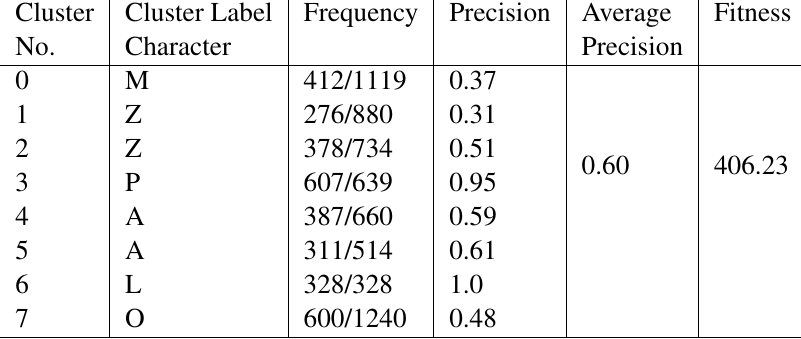
Table 7: K-means algorithm clustering for selected set of characters.